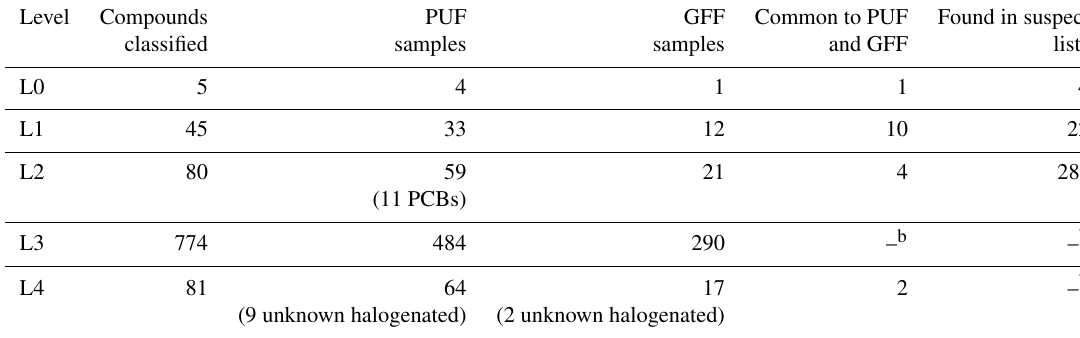
Table 3. Overview of the L0–L4 compounds classified in air samples from Birkenes (southern Norway). Level Compounds PUF GFF Common to PUF Found in suspect classified samples samples and GFF